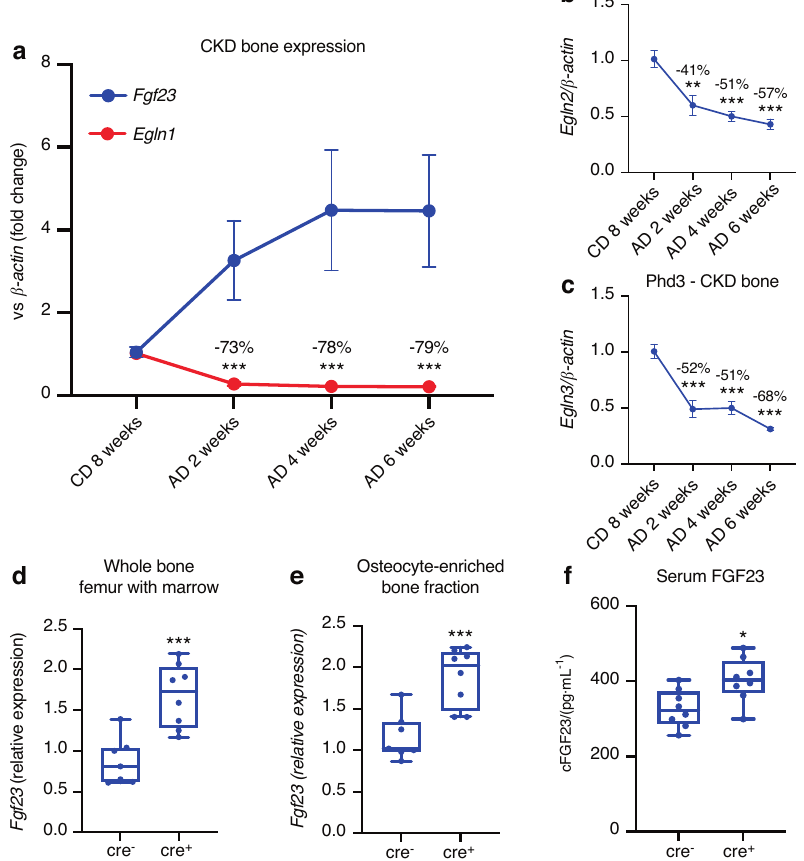
Fig. 3 The role of osteocyte Phd2 in vivo. Wild type (WT) male mice were fed an adenine diet (AD) to induce CKD for 2, 4, or 6 weeks. Mice on casein diet for 8 weeks were used as controls. a Bone Fgf23 (blue) and Egln1 /Phd2 (red) mRNA expression was measured over diet duration. b Male Phd1 and c Phd3 expression in CKD bone. Numbers above timepoints indicate the % decrease in gene expression compared to the casein diet control ( n = 3 – 4 mice/group; ** P < 0.01; *** P < 0.001 vs. casein diet control). Fgf23 mRNA expression in d whole bone (including marrow), e osteocyte-enriched bone fractions, and f plasma total ( C -terminal) FGF23 concentrations in mice with conditional deletion of Phd2 in osteocytes (Phd2- fl / fl /Dmp1-cre + ) compared to mice without deletion (Phd2- fl / fl /Dmp1-cre − ) ( n = 6 mice/genotype; * P < 0.05, *** P < 0.001 vs. cre − and osteocyte-enriched bone fractions (Fig. 3e) was signi fi cantly upregulated in the Dmp1-cre + mice versus cre − controls. Serum intact FGF23 concentrations were similar between cre − and cre + mice (Fig. S4c), whereas plasma total ( C -terminal) FGF23 was found to be modestly elevated in the Dmp1-cre + mice versus cre − mice (Fig. 3f), supporting our hypothesis that Phd2 is upstream of FGF23 and is involved in FGF23 regulation in health and diseased bone in vivo.